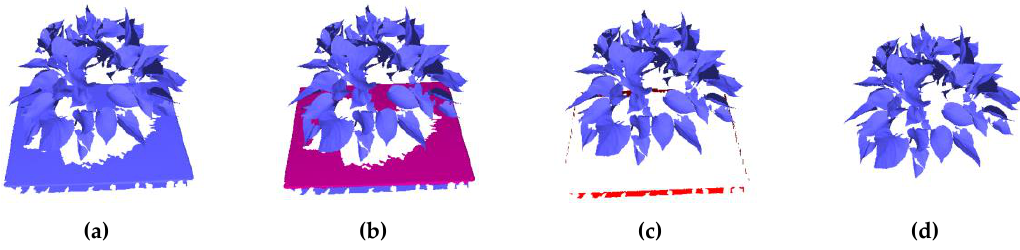
Figure 2. The removal of non-plant. ( a ) An example of the generated 3D mesh model of the plant; ( b ) the detection of the table; ( c ) the filtering of non-plant; ( d ) the plant after the non-plant removal.